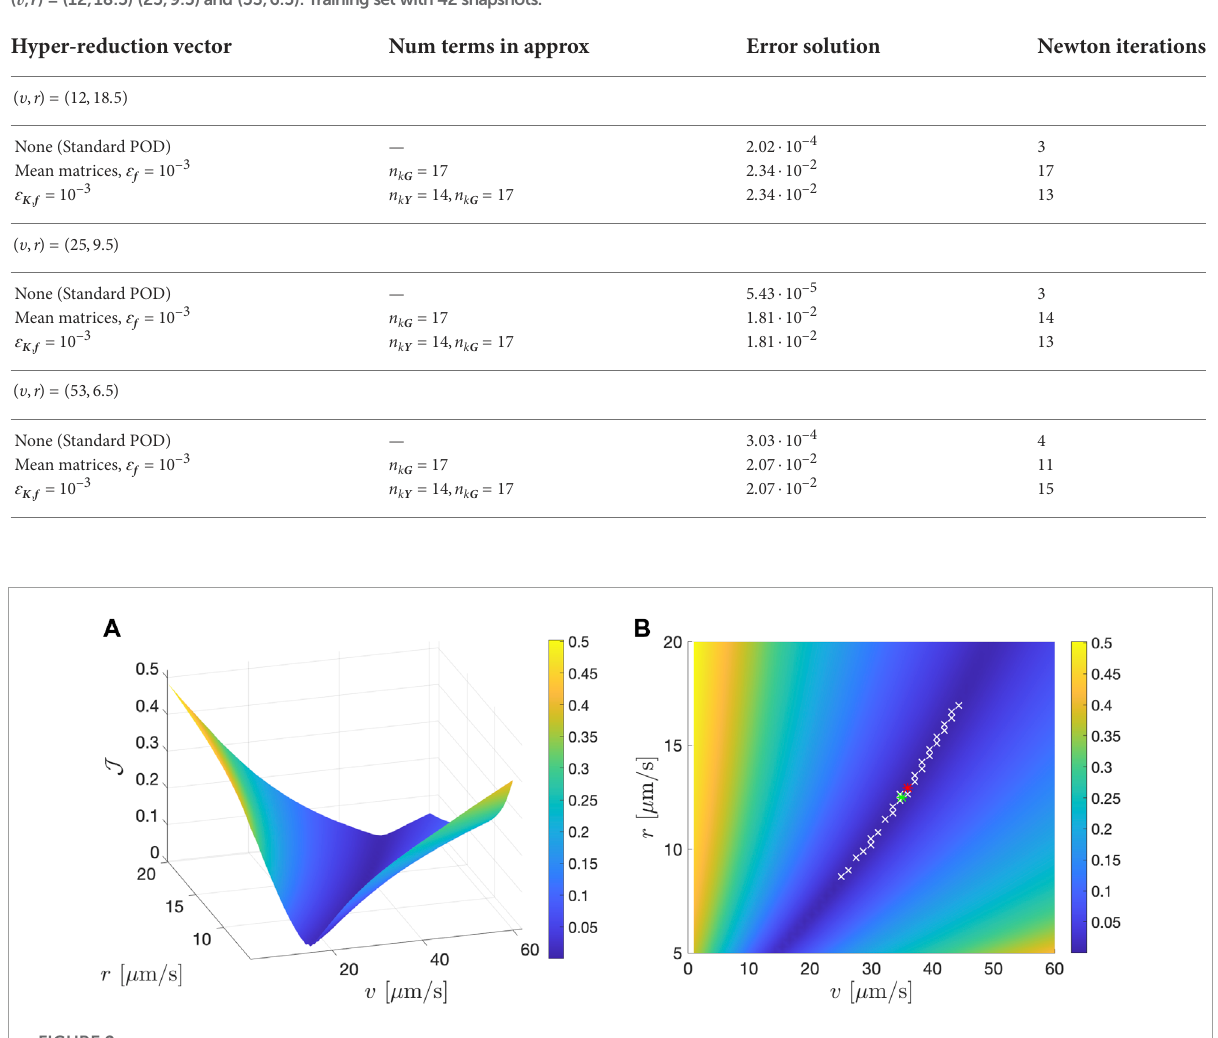
number of Newton iterations for the previous parametric